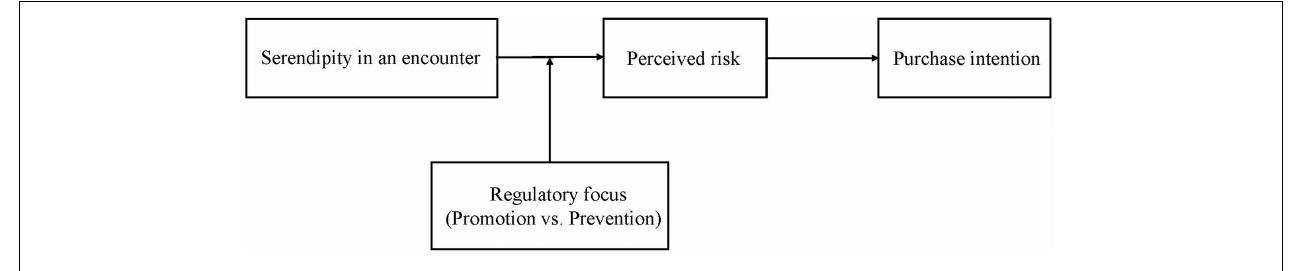
FIGURE 1 | Theoretical